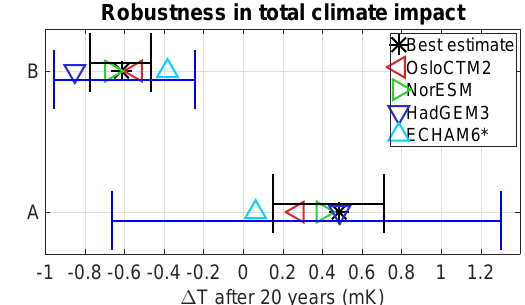
Figure 5. Emission metric-based estimate of change in global mean temperature by 10% reduction in emissions of all SLCFs based on 2008 global emissions with positive best estimate AGTP(20) val- ues (BC, CO, and VOCs, labeled B), and 10% global reduction in all SLCFs (also including OC, SO 2 , and NO x , labeled A). Colored symbols use sets of emission metrics from individual models. The blue bar is given based on summing contributions using all maxima and minima in Fig. 2. The black bar is the uncertainty assuming the metric estimates are all